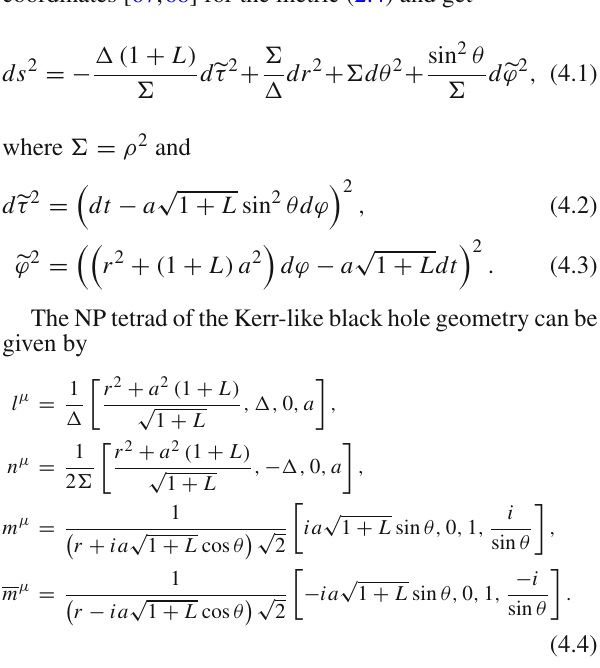
coordinates [67,68] for the metric (2.4) and